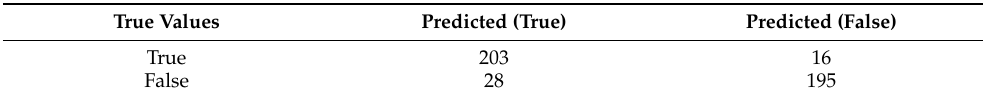
Table 13. Ensemble Model Confusion